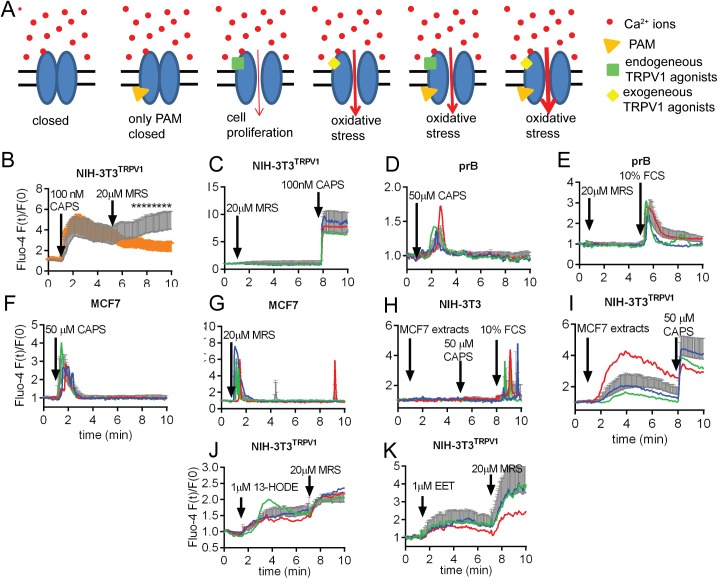
Effect of MRS on TRVPV1-mediated Ca2+ signaling.A) Schematic model of TRPV1 channel modulation by MRS in cancer cells. Homo-tetrameric TRPV1 is permeable to cations, notably Na+ and Ca2+. I) In the absence of TRPV1 agonist the channel is closed. II) Binding of a positive allosteric modulator (PAM) alone, e.g. MRS, does not activate channel opening. III) Endogenous TRPV1 agonists present in the tumor microenvironment are weak stimulators of TRPV1, possibly involved in tumor progression. IV) Exogenous agonists such as CAPS are potent TRPV1 activators. Resulting from TRPV1 hyper-activation, CAPS induces oxidative stress. V-VI) MRS amplifying the effect of both endogenous and exogenous agonists may evoke a more pronounced cytotoxic effect (oxidative stress). B-I) Acute effects of MRS on the intracellular Ca2+ regulation in various cell types. The different substances were added at the time points indicated by arrows and remained in the solution until the end of the experiments B) Fluorescence recordings from time-lapse videos show an increase in [Ca2+]i after CAPS administration in NIH-3T3 cells stably transfected with the TRPV1 channel. Traces represent mean + SD. More than 20 single cell recordings were evaluated (n > 20). MRS added at t = 5 min evoked a second long-lasting elevation in [Ca2+]i. (gray curve). In cells stimulated by CAPS only, [Ca2+]i continuously decreased after the initial peak at approximately 2 min (orange curve). Statistically significant differences between the two curves (Student t-test, p<0.05) are marked with asterisks. C-I) Single-cell (colored traces) and average fluorescence recordings of the entire cell population (grey traces) from time-lapse videos show changes in [Ca2+]i. Bars represent SD. All experiments were repeated two or more times with similar results. C) NIH-3T3TRPV1 cells responded to CAPS with an increase in [Ca2+]i, but not to MRS alone. D) Primary breast epithelial cells (prB) responded to CAPS with a brief increase in Ca2+]i often lasting for less than a min. E) Primary breast epithelial cells did not respond to MRS1477 alone, but responded to serum re-administration. F) MCF7 breast cancer cell line responded to CAPS alone and G) to MRS1477 alone with brief Ca2+ transients. H) Neither MCF7 cell extracts nor CAPS (50 μM) evoked an elevation in Ca2+]i in control (un-transfected) NIH-3T3 cells; a Ca2+ signal was induced by serum re-administration I) Application of a MCF7 cell extract increased [Ca2+]i in NIH-3T3TRPV1 cells; the Ca2+ signal was further increased by CAPS (50 μM). J-K) MRS augmented the endogenous agonist-evoked rises in [Ca2+]i. The initial rise in [Ca2+]i was evoked either by 13-HODE (1 μM) (J) or by 8,9-EET (1μM) (K).